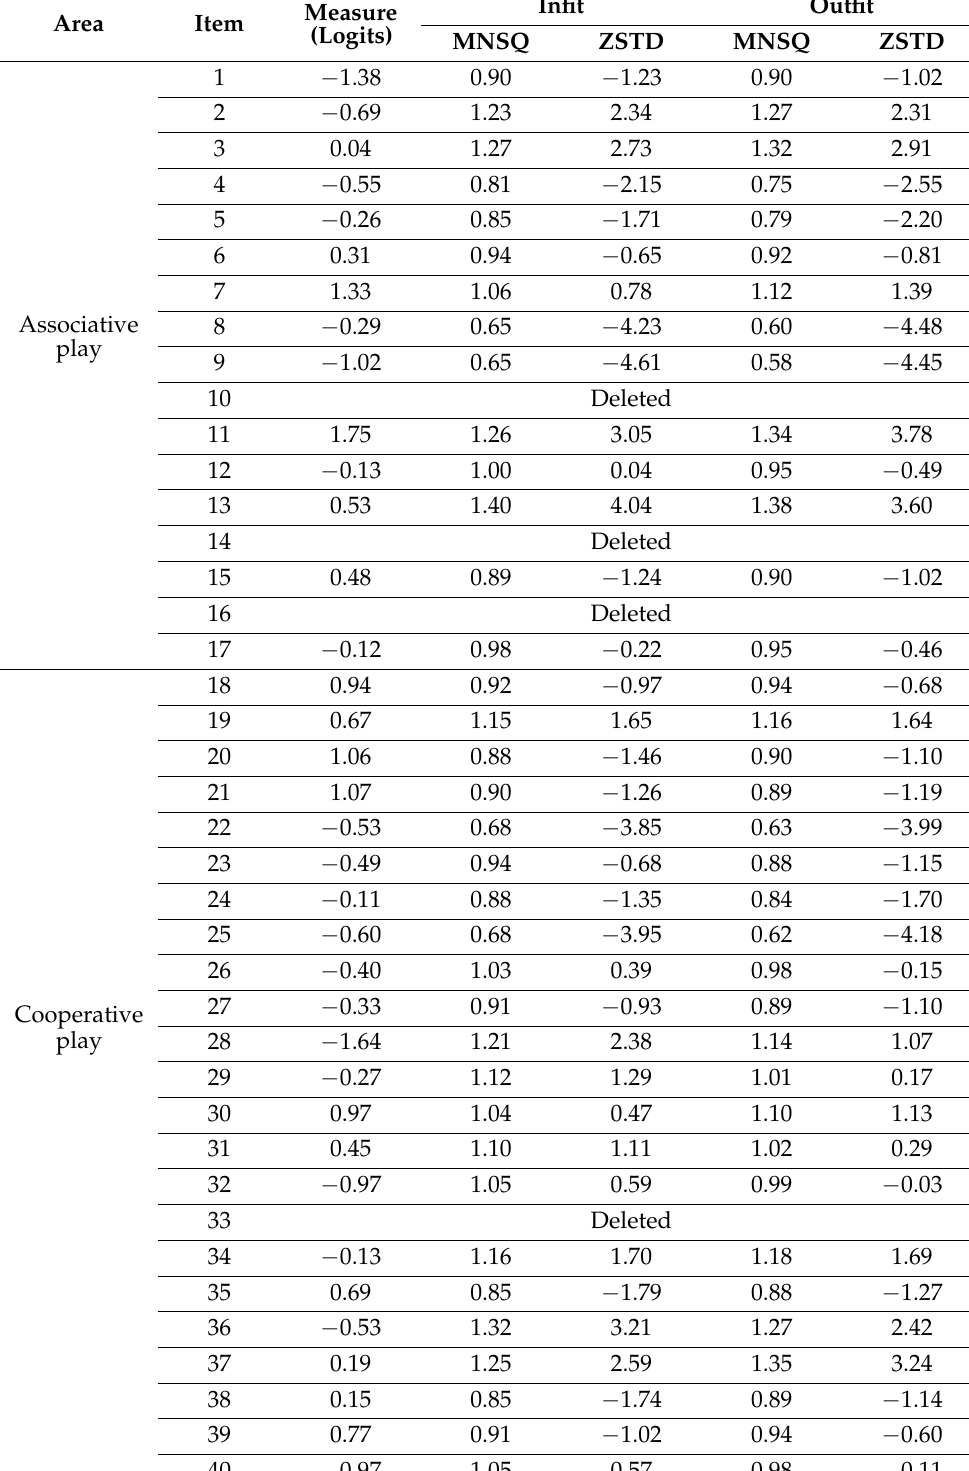
Table 1. Item fit statistics on associative play and cooperative